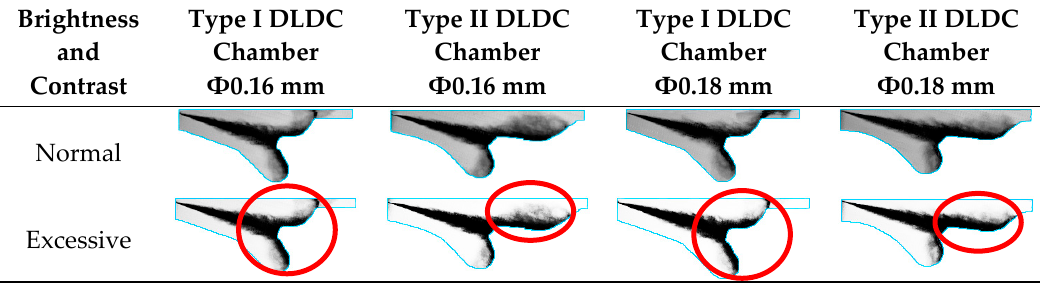
Figure 18. The comparison of fuel spray distributions at 1.4 ms ASOI under different brightness and contrast with full load, different nozzles, 150 injection pressure and 15 °CA BTDC injection timing of Mode C.